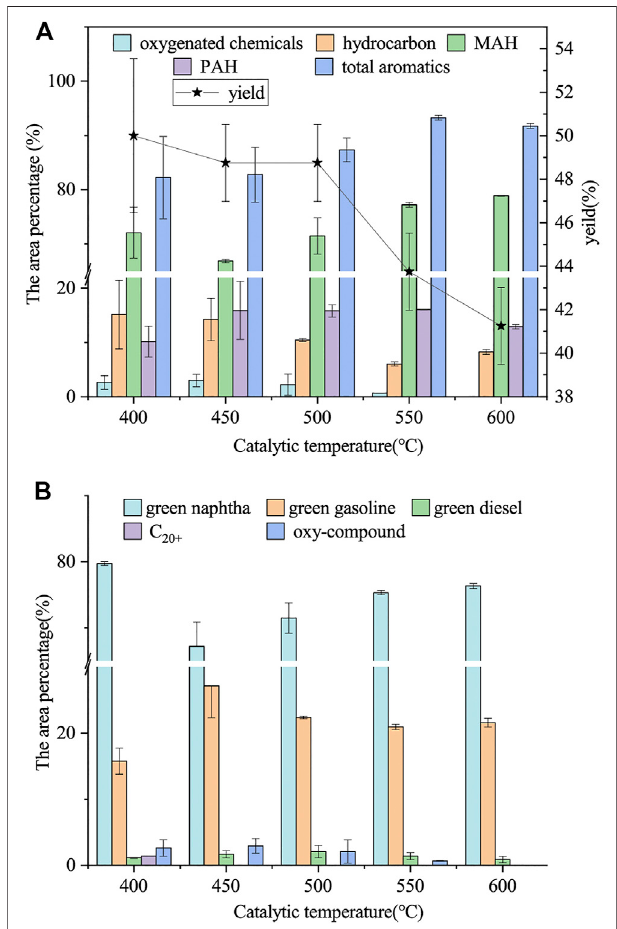
FIGURE 6 | Effect of catalytic temperature on bio-oil. (A) Area percentageofthebio-oilcontainingoxy-compound, hydrocarbon(alkeneand alkane), MAH, PAH, the total aromatics, and the bio-oil yield; (B) area percentage of oxy-compound, C 20+ hydrocarbons, green diesel (C 13 – C 20 ), green gasoline (C 10 – C 12 ), and green naphtha (C 5 – C 9 ) in bio-oil.